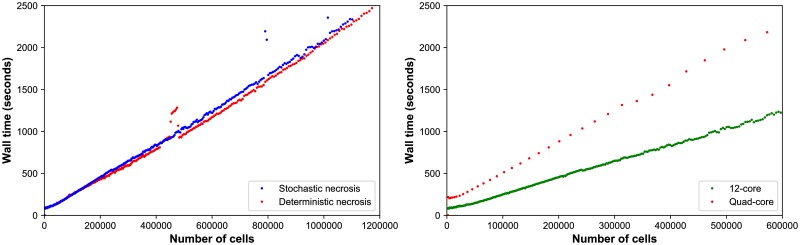
HDS computational cost scaling.Left: Wall-time vs. cell count for the stochastic (red) and deterministic (blue) necrosis necrosis models on a single HPC compute node. Both models show approximately linear cost scaling with the number of cell agents. Right: Wall time vs. cell count for stochastic necrosis model on the desktop workstation (orange) and the single HPC node (green).